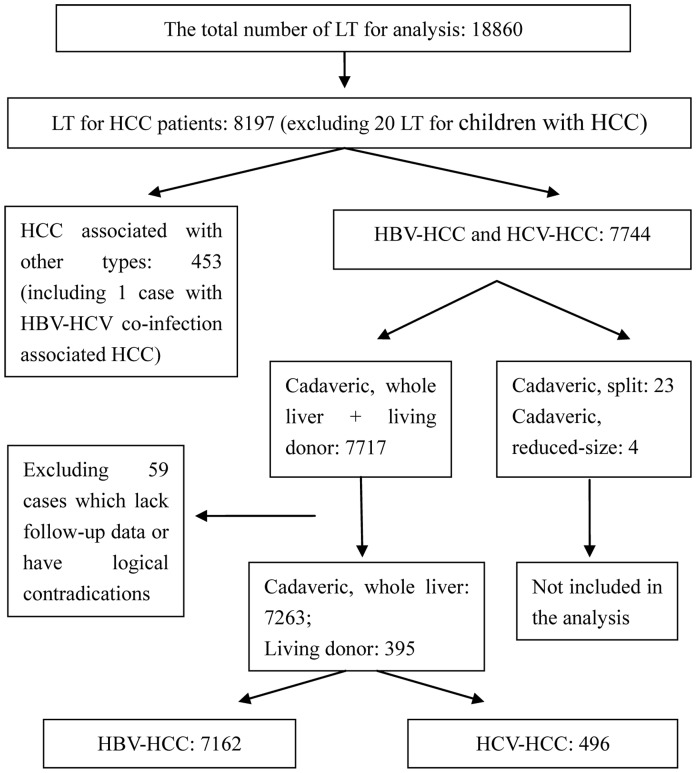
Flow chart of patient selection.